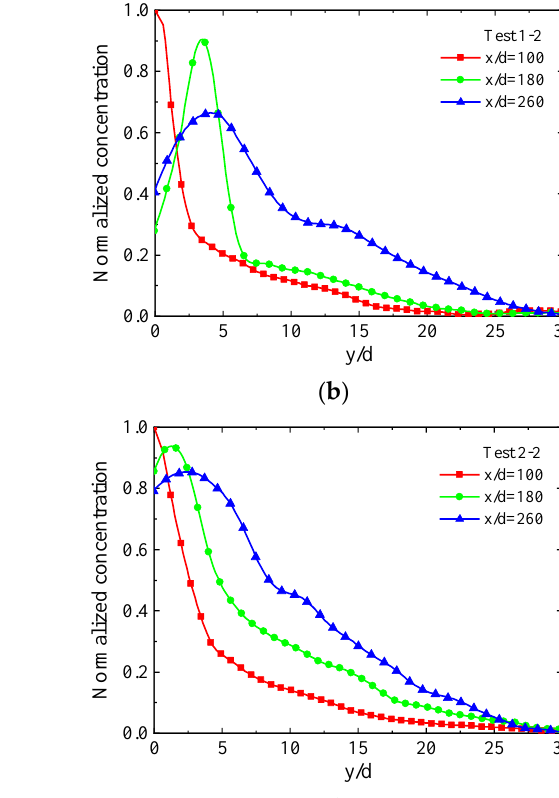
( d ) Figure 14. Comparison of concentration curves obtained by experiments and simulations. ( a ) Ma = 2.0, P j = 2.8 MPa, T j = 705 K. ( b ) Ma = 2.0, P j = 2.8 MPa, T j = 730 K. ( c ) Ma = 2.0, P j =4.2 MPa, T j = 707 K. ( d ) Ma = 2.0, P j = 4.1 MPa, T j = 735 K. Figure 15 shows the concentration curves of the EHF jet along the flow direction at Ma 2.0 (Tests 1-1, 1-2, 2-1, and 2-2). The curve data are extracted and normalized from the central concentration contour for the EHF plume at flow distances x/d of 100, 180, and 260. As can be seen, the highest concentration point starts from the near-wall region (x/d